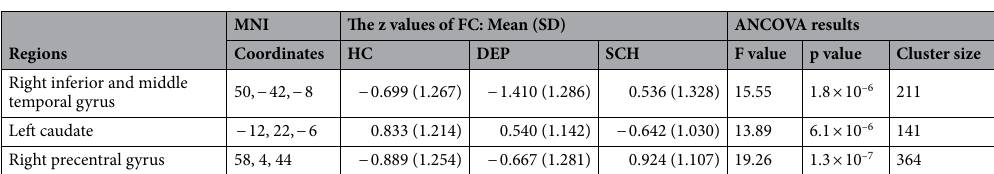
Figure 3. ( A ) Differences of salience network (SN) functional connectivity (FC) in the healthy controls (HC), schizophrenia (SCH), and depression (DEP) by the ANCOVA (voxel-wise p < 0.001 uncorrected and a cluster- wise threshold of p < 0.05, FWE-corrected), and the colorbar represents F values; ( B ) post-hoc comparisons found that the schizophrenia group showed increased SN-right inferior and middle temporal gyrus (ITG and MTG) FC and SN-right precentral gyrus, as well as increased SN-left caudate in SCH group compared to the other two groups (p < 0.01), the Depression group showed decreased FC SN-right ITG and MTG FC compared to the other two groups (p < 0.05).